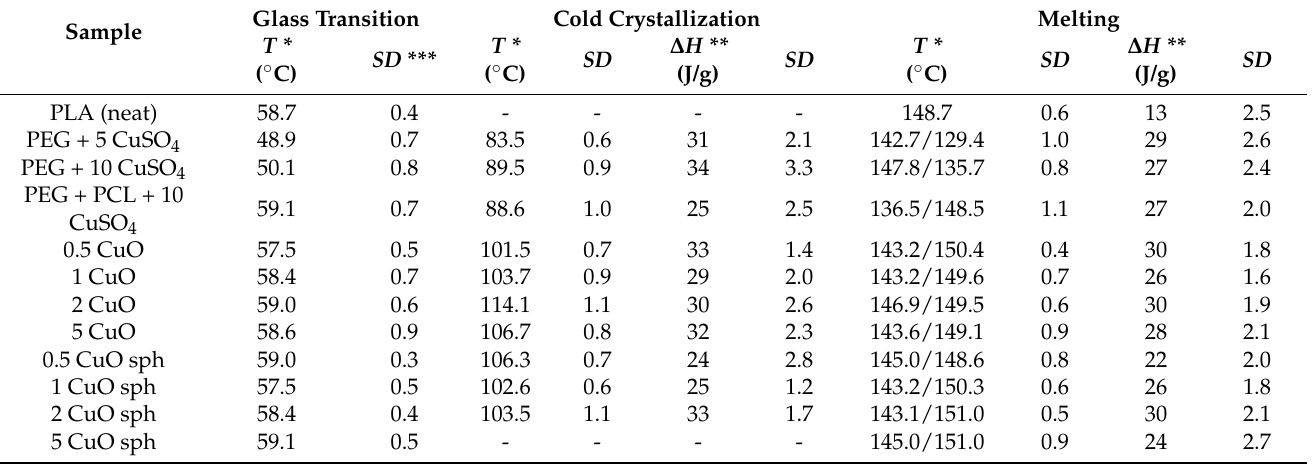
Table 5. Thermophysical properties of neat PLA and PLA as a component of the obtained composites (first